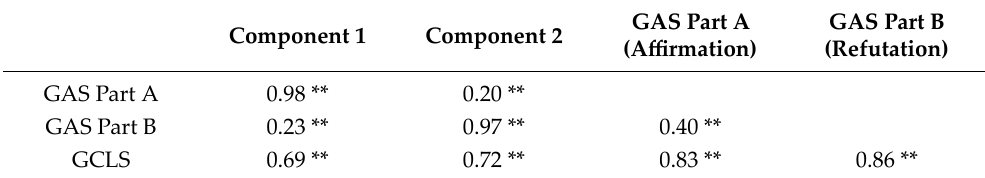
Table 2. Correlation matrix for GAS PCA components and total scores for Part A and B and the scale’s total